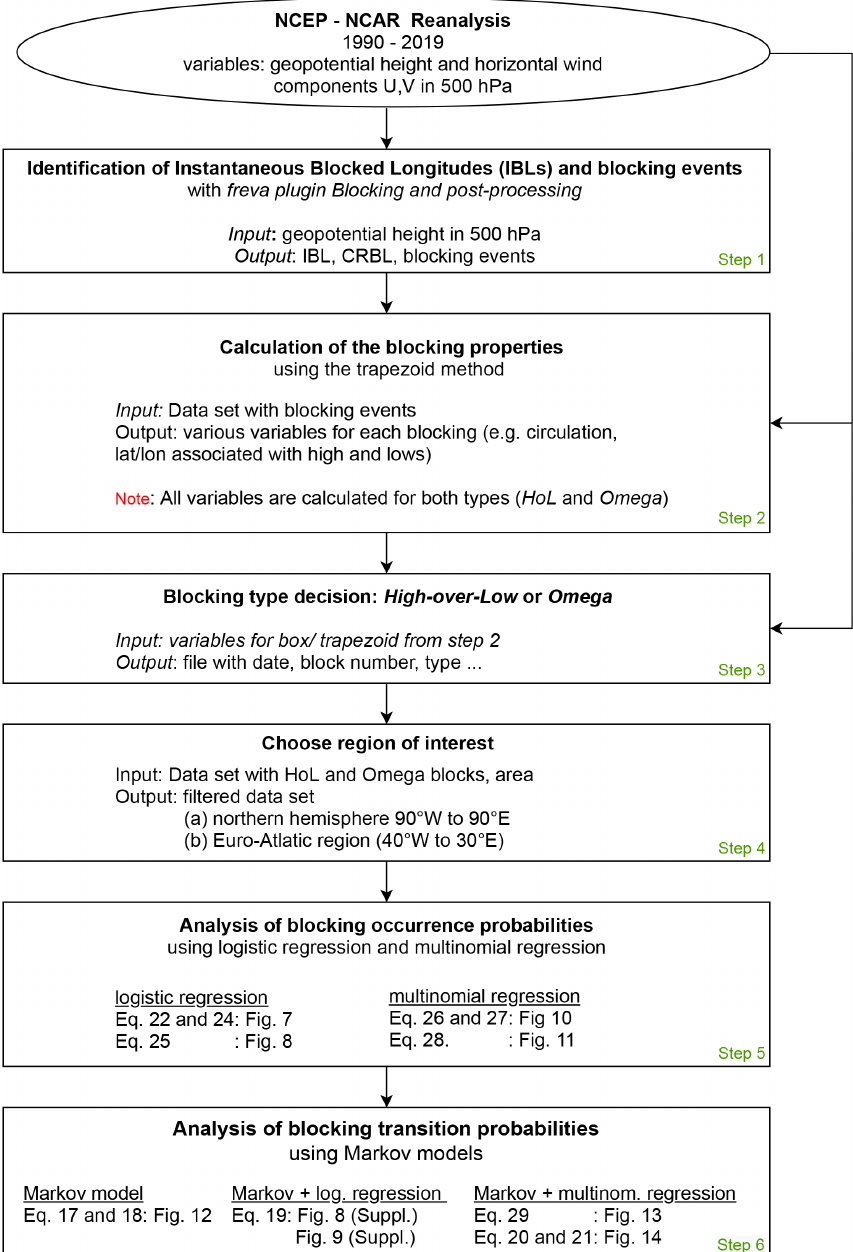
Figure 2. Structure diagram of the individual steps of the evaluation as explained in Sect. 3.